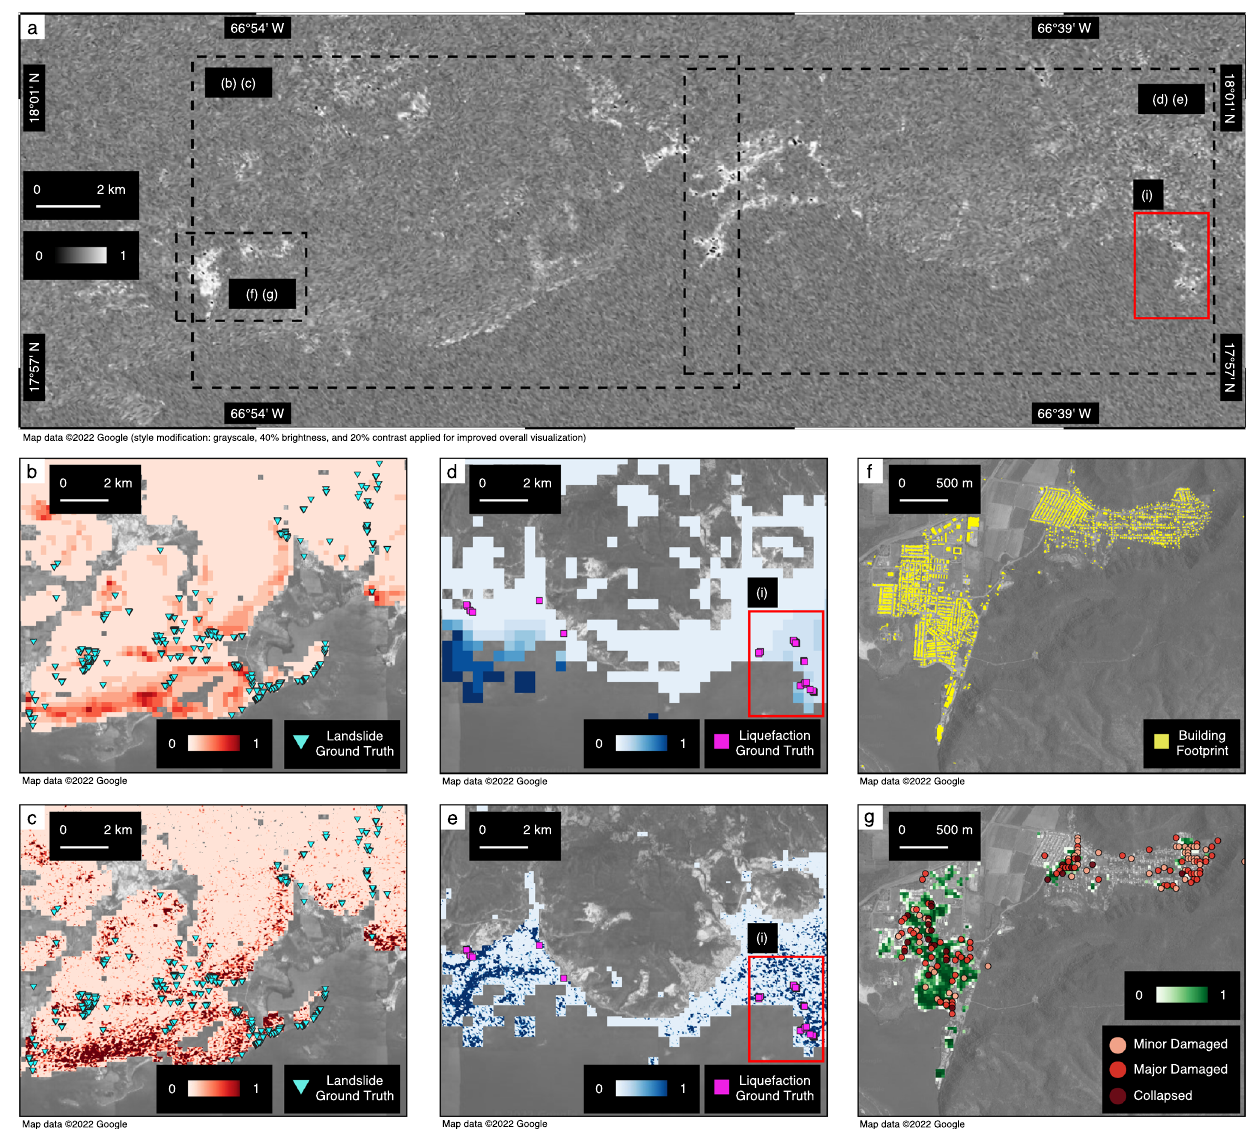
Fig. 3 | Geospatial prior and posterior estimation models of the 2020 Puerto Ricoearthquake.a Damageproxymap(30-mresolution)withrectangularextents ofeachfocusedarea. b Priorlandslideestimatesinredandgroundtruth(triangles). c Posterior landslide estimates in red and ground truth (triangles). d Prior